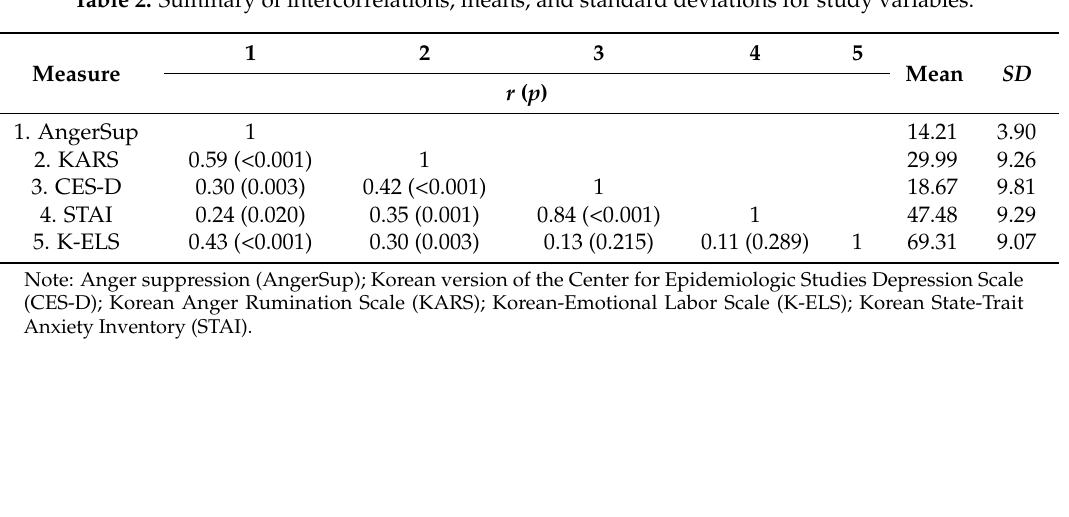
Table 2. Summary of intercorrelations, means, and standard deviations for study